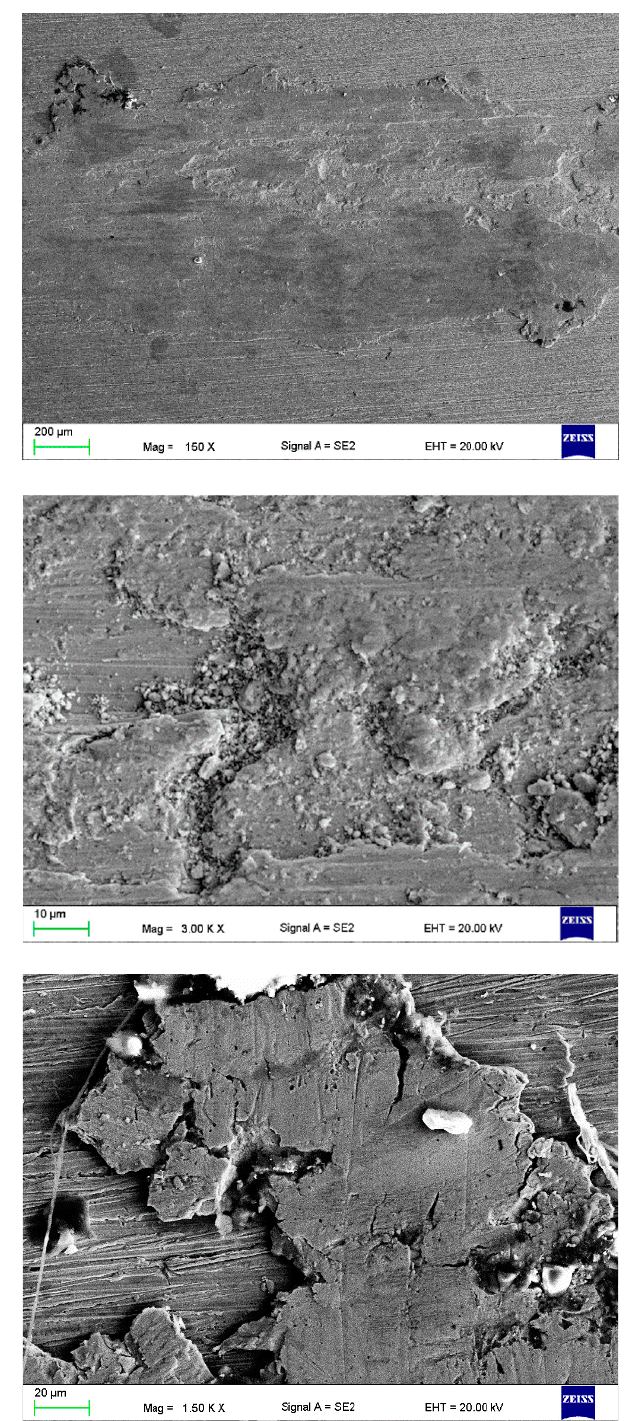
Figure 17. Wear track ( a , b ) of the tested CrAl v = 0.4 mm 3 /min layer and ( c ) wear debris.